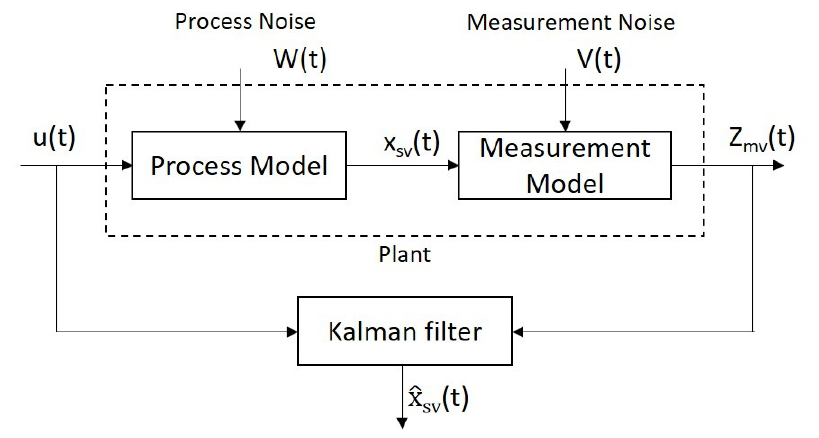
Figure 7. Illustration of the continuous-time KF